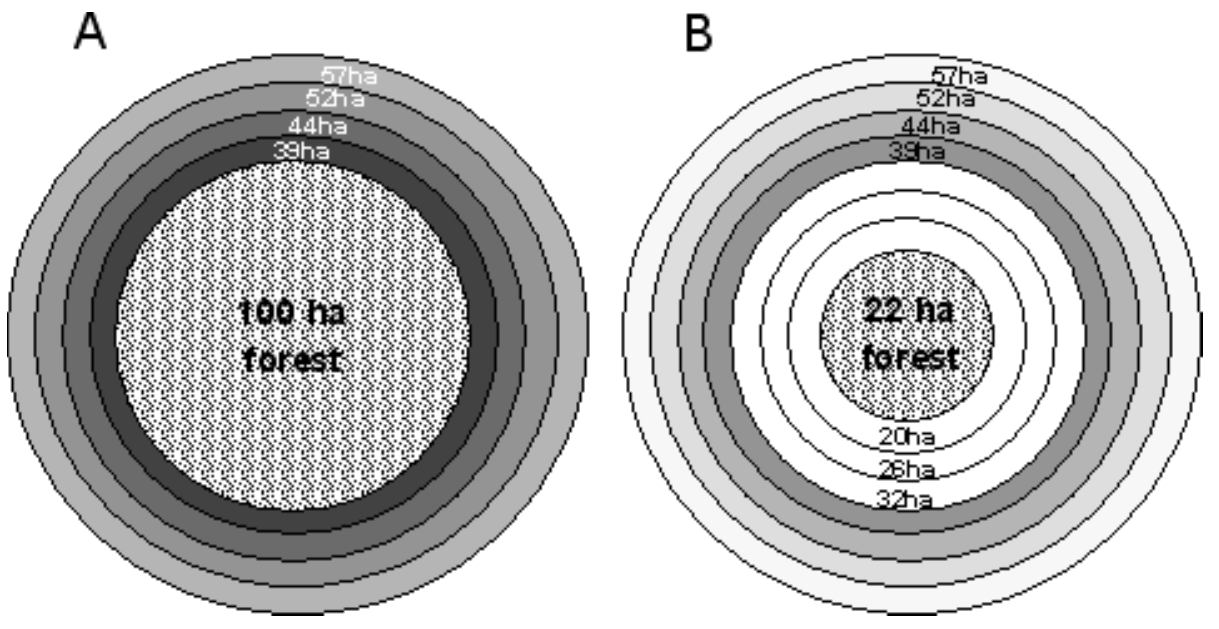
Fig. 3. Coffee-growing area and deforestation scenarios. Comparison of (A) 100-ha and (B) 22-ha forest remnants; the surrounding circular areas indicate increasing distances to the central forest area (the width of one ring is 100 m). The figure is drawn to scale. We calculated the effect of forest distance on agroforestry systems situated within these rings (100–400-m distances). The extent of gray shading reflects the decline in pollination services; white areas indicate the replacement of forest by alternative